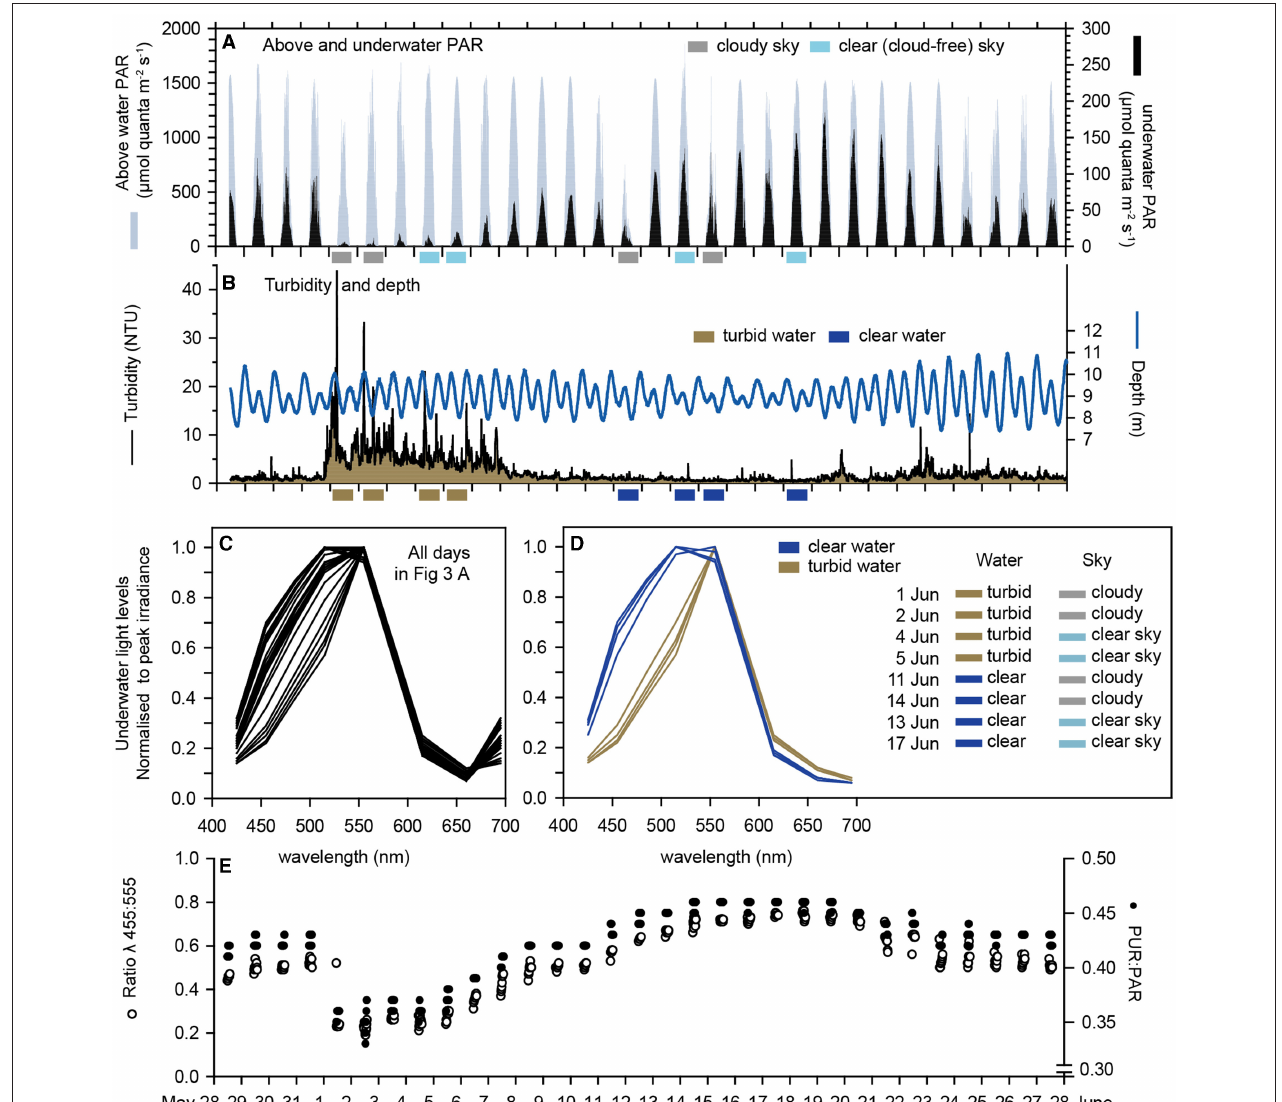
FIGURE 3 | Multispectral sensor data: (A) Underwater PAR at 8m depth at Florence Bay and above water PAR at the weather station beside Florence Bay (Figure 1) from 28 May to 28 June (2017) which encompassed the austral winter solstice (21 June). (B) Turbidity (NTU) at the seabed (8m) at Florence Bay and depth (m). (C) The ratio of λ 455nm to λ 555nm light and PUR/PAR. (D,E) Normalised irradiance spectra from the underwater multispectral light sensor at Florence Bay over a 2h period centred on midday for all days and 8 days showing the effects of high and low turbidity with and without cloud cover (see text).